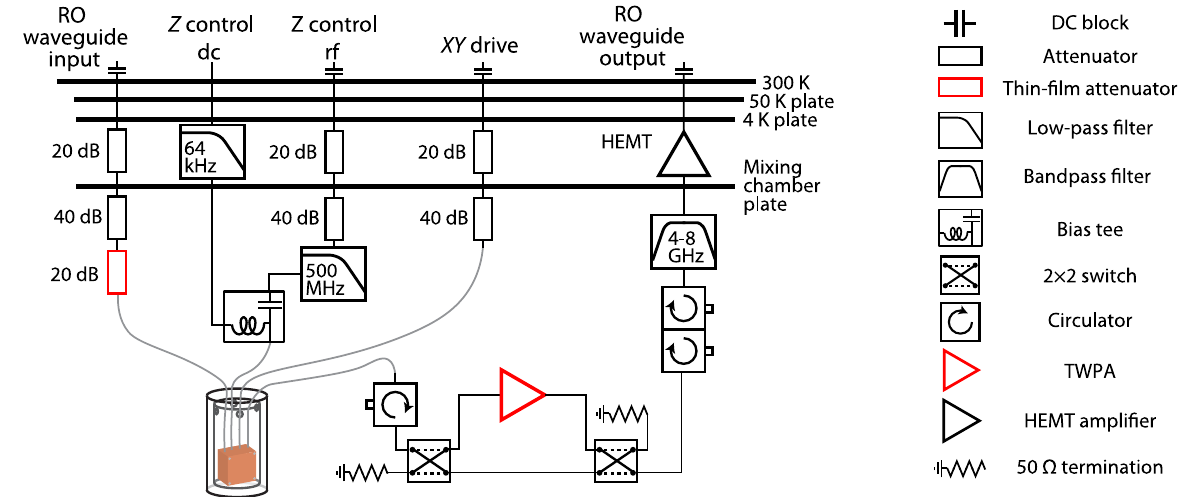
FIG. 17. Schematic of the measurement setup inside the dilution refrigerator for device II. The meaning of each symbol in the schematic on the left is enumerated on the right. The level of attenuation of each attenuator is indicated with number next to the symbol. The cutoff frequencies of each filter are specified with numbers inside the symbol. Small squares attached to circulator symbols indicate port termination with Z 0 ¼ 50 Ω , allowing us to use the three-port circulator as a two-port isolator. The pump line for the TWPA is not shown in the diagram for